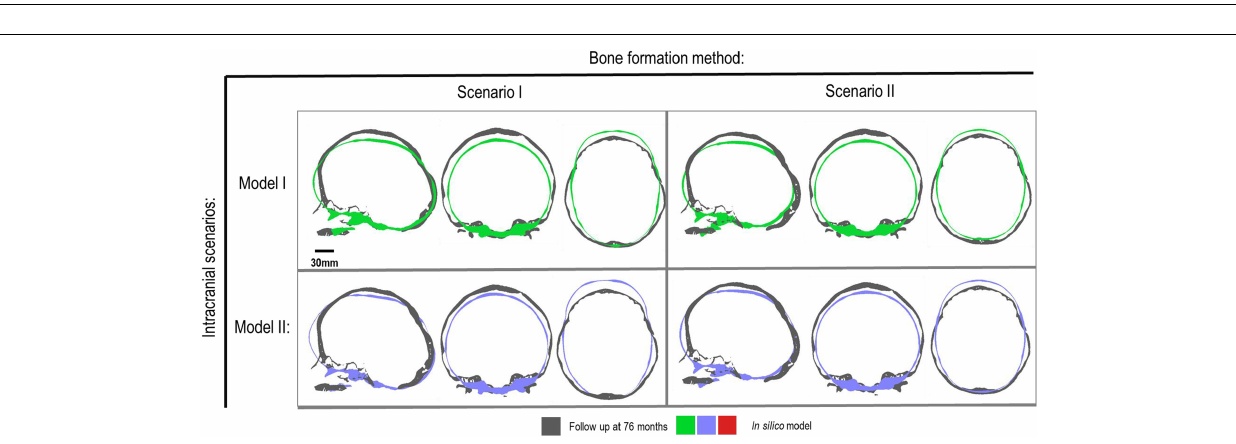
FIGURE 4 | Bone formation methods under scenario I (bottom) and scenario II (top) during calvarial growth, sagittal and dorsal views (1:1 scale).